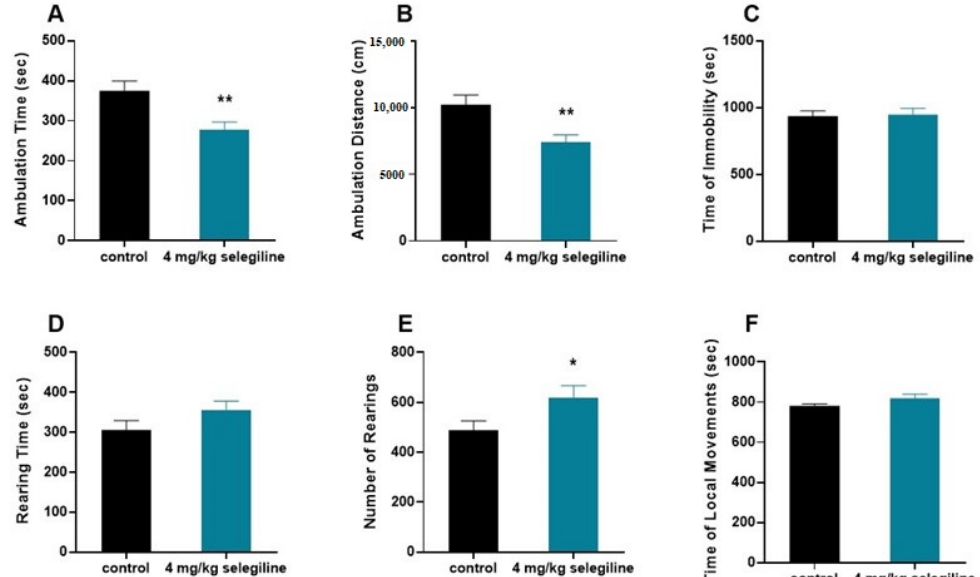
Figure 5. Effect of selegiline (4 mg/kg) on various patterns of locomotor activity of BALB/c mice. The horizontal activity (ambulation; ( A , B )), the vertical activity ( D , E ), and the immobility time and local movement time ( C , F ) were tested. The observation period lasted 40 min. The control group received tap water ( n = 9). The treatment group received 4 mg/kg selegiline dissolved in their drinking water ( n = 9). All data are presented as mean ± S.E.M. Unpaired t -test, * p < 0.05, ** p <